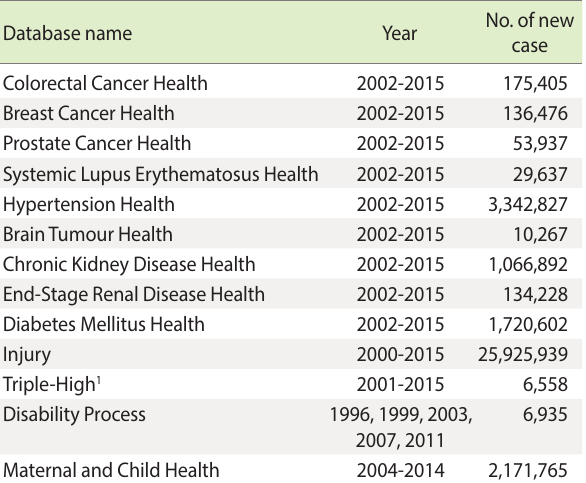
Figure 3. Data structure of the National Health Insurance Research